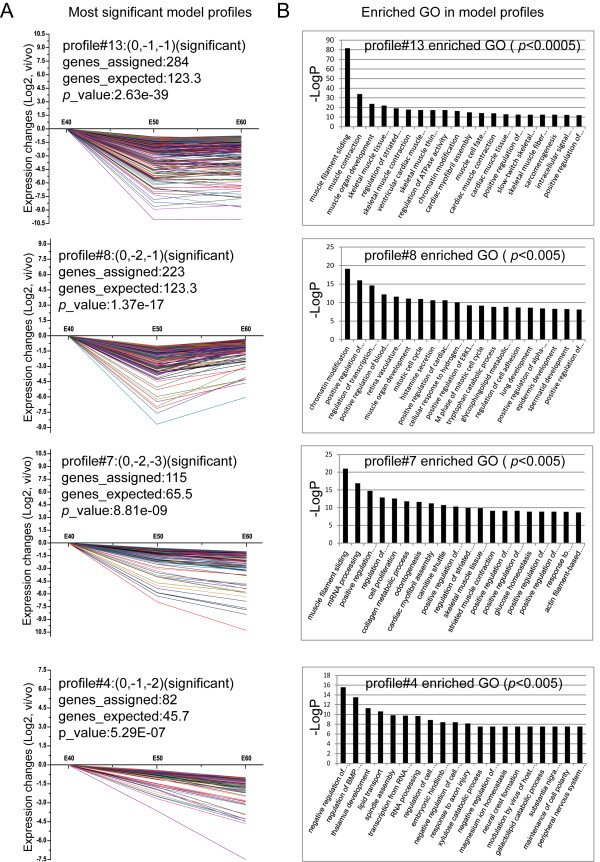
STC-GO analysis. (A) The most significant gene expression tendencies of profiles 4, 7, 8, and 13 showed predominantly down-regulation patterns of gene expression. The horizontal axis represents stages, and the vertical axis shows the time series of gene expression levels for the gene after Log normalized transformation. The value in brackets after the profile represents the variation intensity, the genes assigned represent the gene number in each profile, the genes expected represent the theoretical gene number in each profile, and the p-value indicates significance. (B) The significant enriched GO terms in profiles 4, 7, 8, and 13.